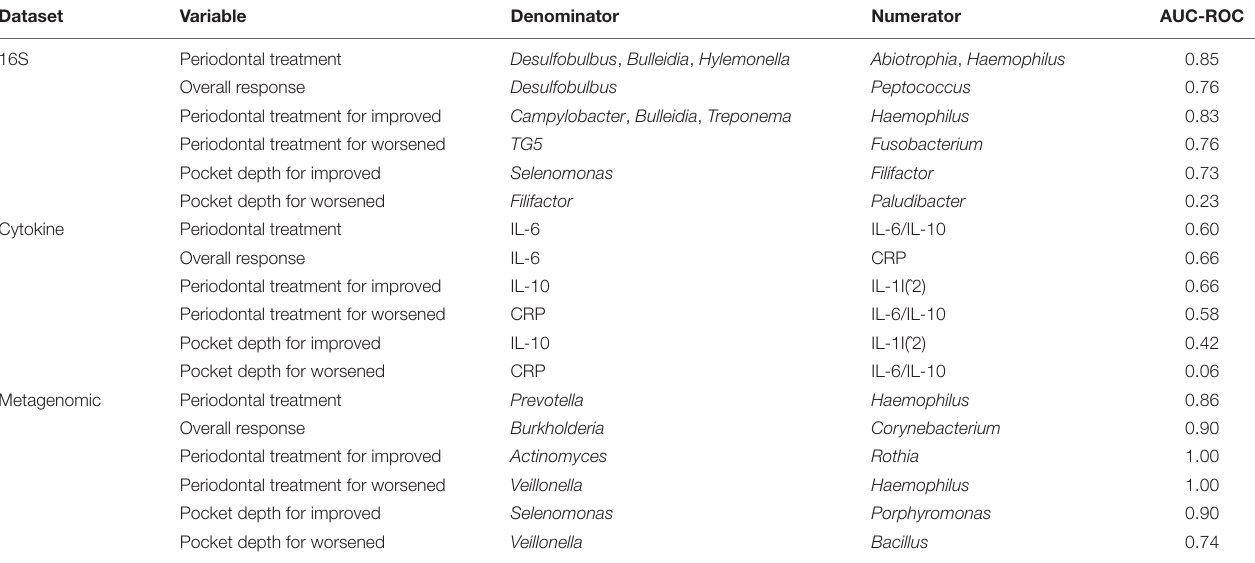
FIGURE 4 | Circos plots show 16S and other features with inter-omics links indicating positive or negative correlations with an R 2 greater than 0.5 between (A) the periodontal treatment (PT) study for the improved and worsened samples with the strongest correlation (0.6) for IL-6/IL-10 positively correlated with Schwartzia and Treponema and (B) the sodium hypochlorite (SHT) study for correlations with an R 2 greater than 0.7 for disease classes “A” and “C.” Bold labels were the strongest correlations. TABLE 2 | Summary of the microbial and metabolic balances generated from the periodontal treatment (PT) datasets.